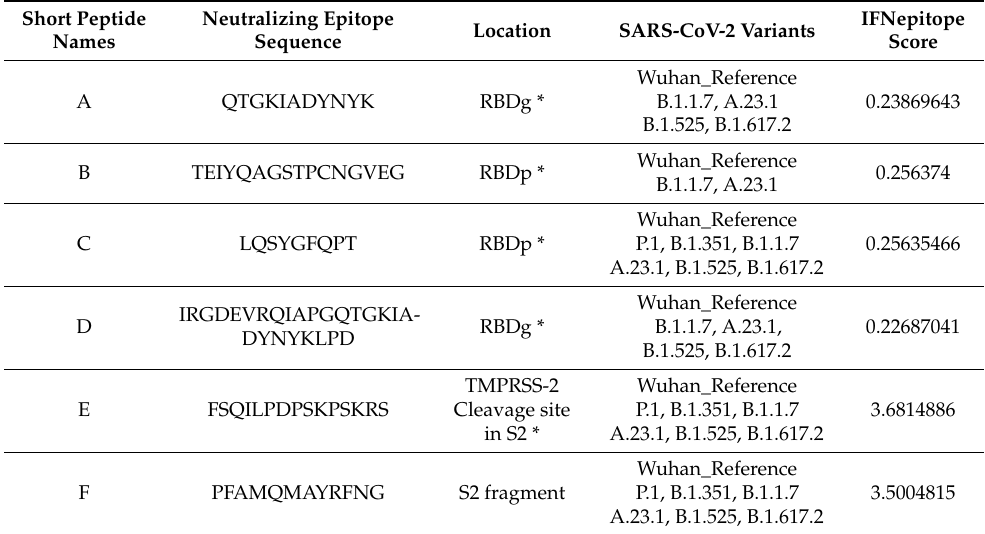
Table 1. Bepipred 2.0 positive predictions (scoring > 0.5) for linear neutralizing epitopes covering targeted RBD and cleavage segments of the spike glycoprotein with targeted SARS-CoV-2